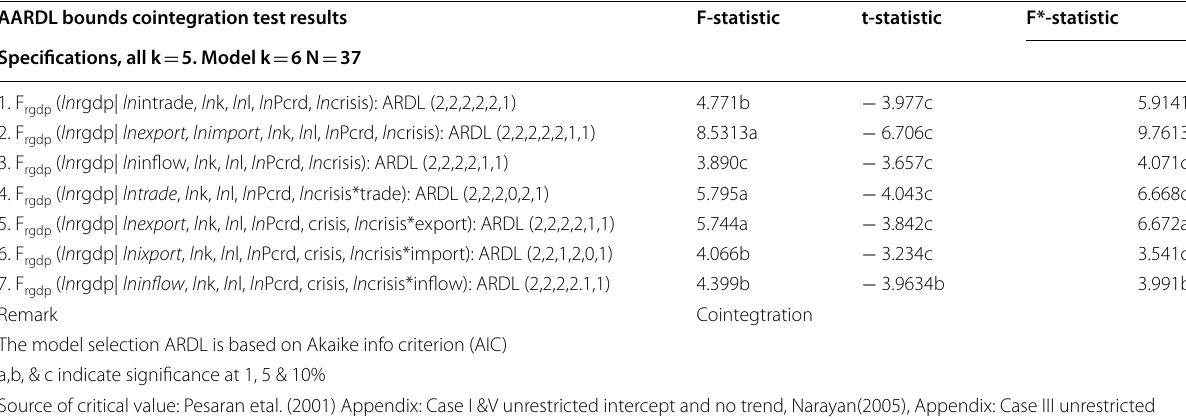
a, b and c indicate 1%, 5% and 10% level of significance Table 4 Augmented ARDL bound test cointegration. Source: author’s computation AARDL bounds cointegration test results F-statistic